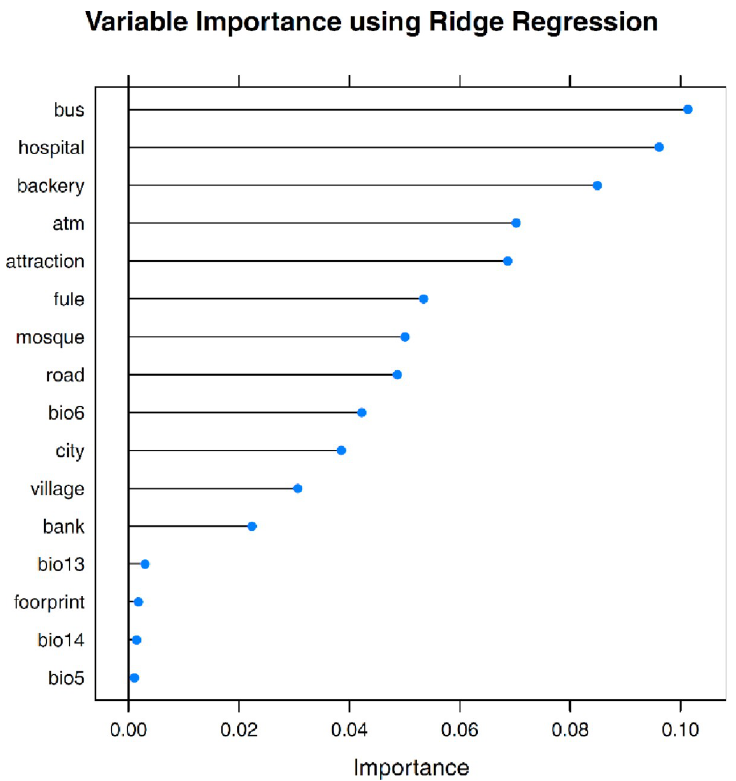
Fig 6. Variable importance of each effective factors (bus: Distance from bus stations; hospital: Distance from hospitals; bakery: Distance from bakeries; atm: Distance from ATMs; attraction: Distance from attraction sites; fuel: Distance from fuel stations; mosque: Distance from mosques; road: Distance from road; bio6: MTCM; city: Density of cities; village: Density of villages; bank: Distance from banks; bio13: MTWM; footprint: HFP, bio14: PWM; bio5: